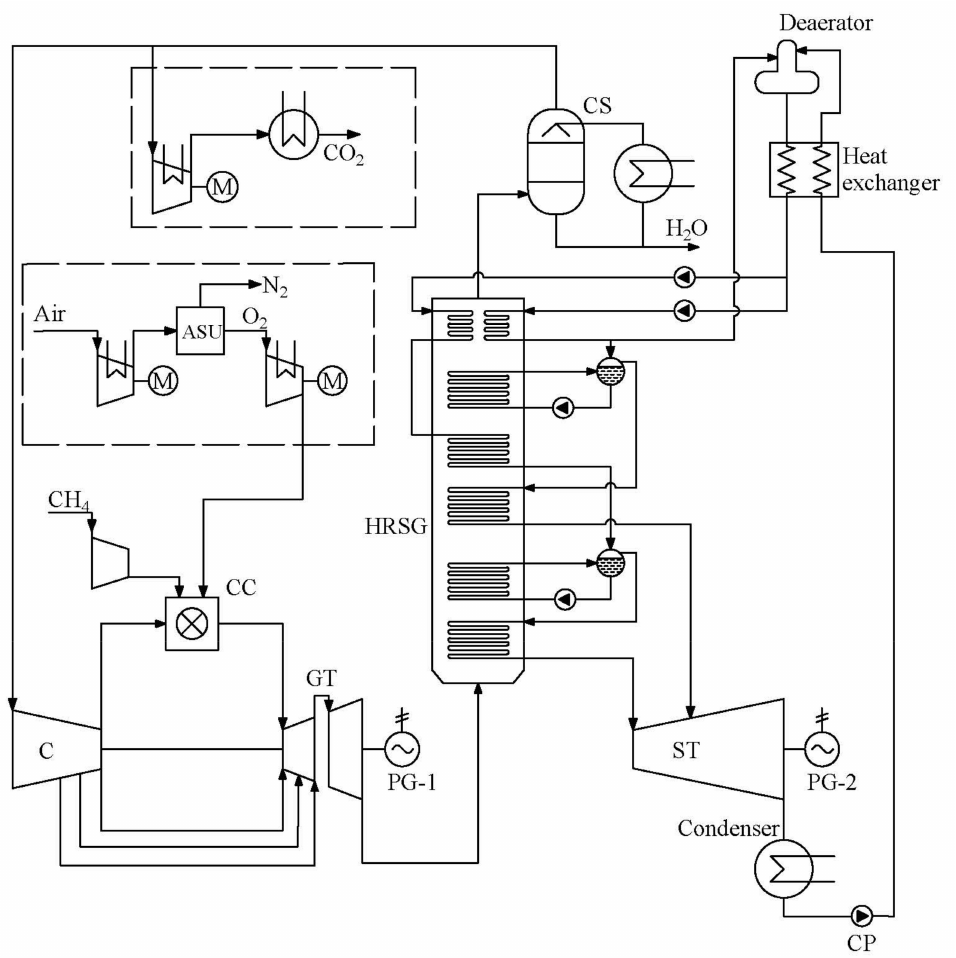
Figure 1. The semiclosed oxy-fuel combustion combined cycle (SCOC-CC) flow